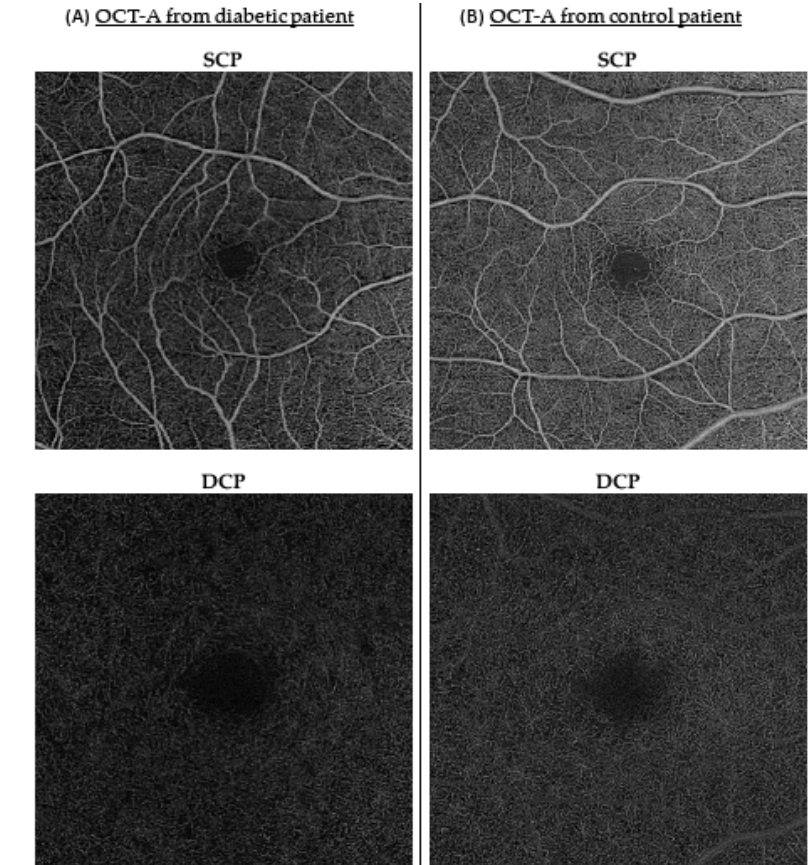
Figure 1. Examples of OCT-A images: illustrations of SCP and DCP in a diabetic patient ( A ) and control patient ( B ). OCT-A: optical coherence tomography angiography; SCP: superficial capillary plexus; DCP: deep capillary plexus.